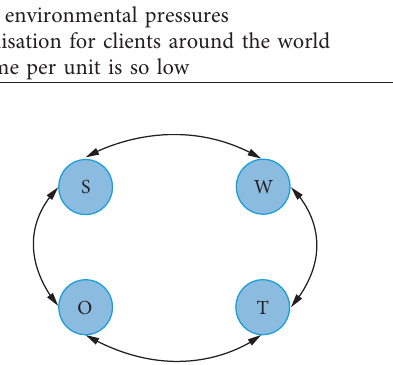
Figure 4: Interior dependence between SWOT